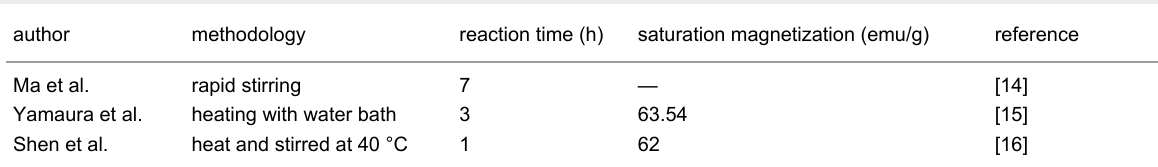
Table 1: Comparing the conventional methods of grafting APTES on SPION.